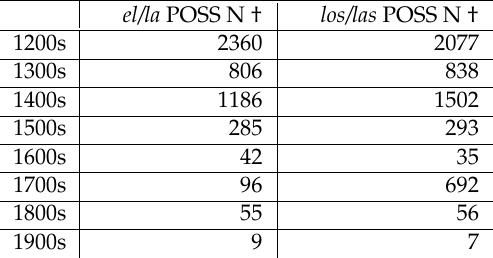
Table 11. Indefinite article + POSS + N in CdE (raw occurrences).